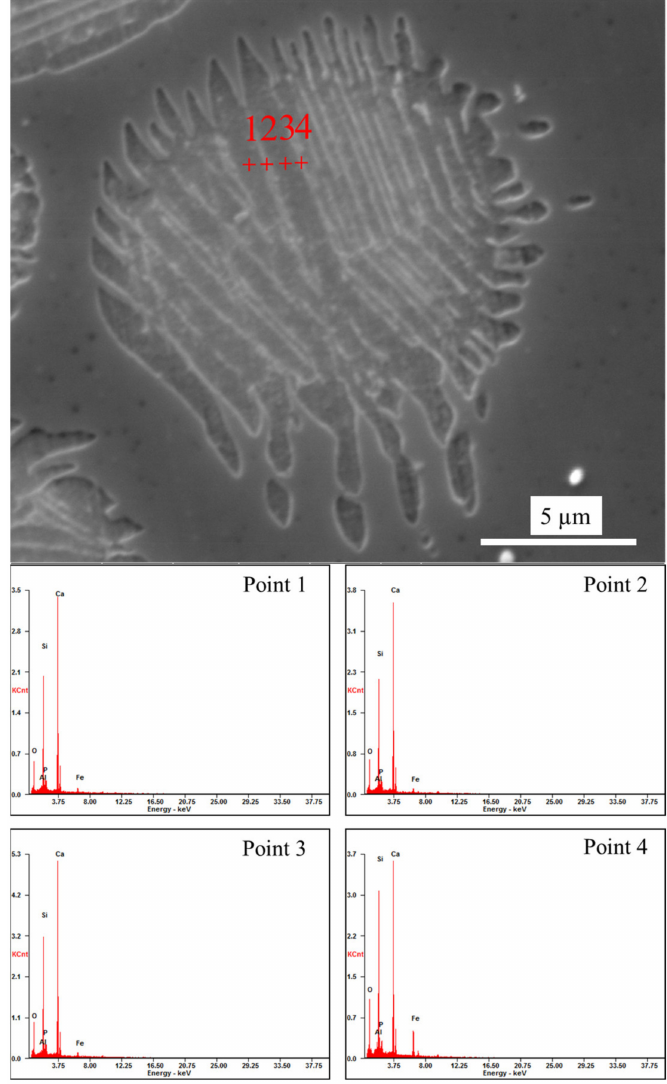
Figure 9. SEM micrograph of a shed small